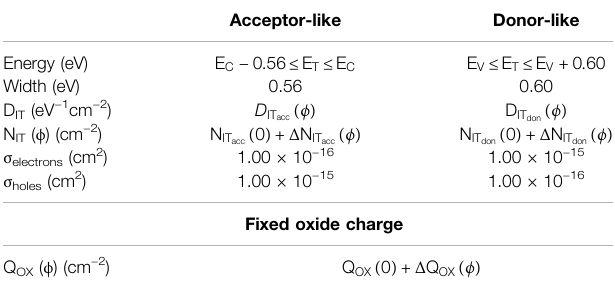
TABLE 1 | Details of the “ Perugia 2019 Surface ” damage modeling scheme. Acceptor-like